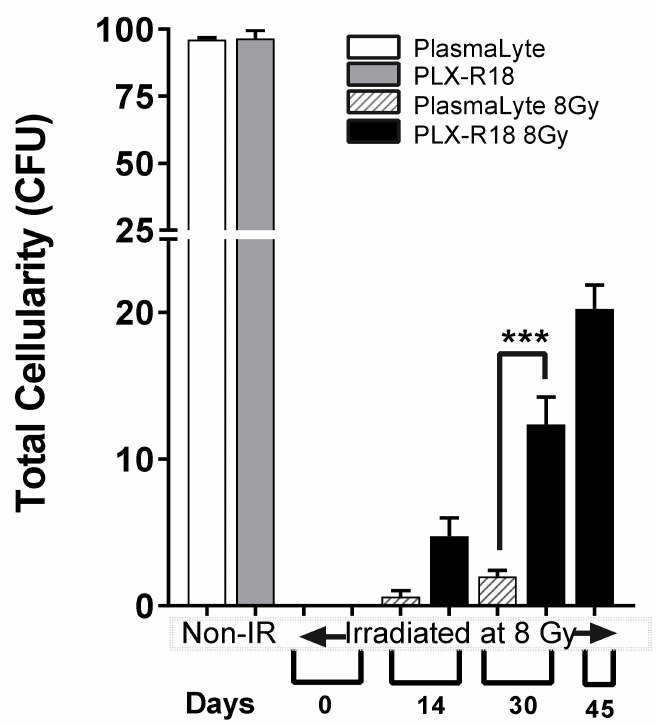
Figure 3. Effect of 8 Gy TBI on femoral bone marrow. Clonogenic potential of bone marrow cells was assessed by a CFU assay. Colony forming units (CFU) were assayed on days 1, 14, 30 and 45 after exposure. Cells from three femurs were pooled, counted, and each sample plated in duplicate to be scored 14 days after plating. Data are expressed as mean ± Standard error of mean (SEM). No statistically significant difference was determined between irradiated and naïve groups. Non- irradiated but administered with either PlasmaLyte or PLX-R18 were used as controls. *** indicates p =